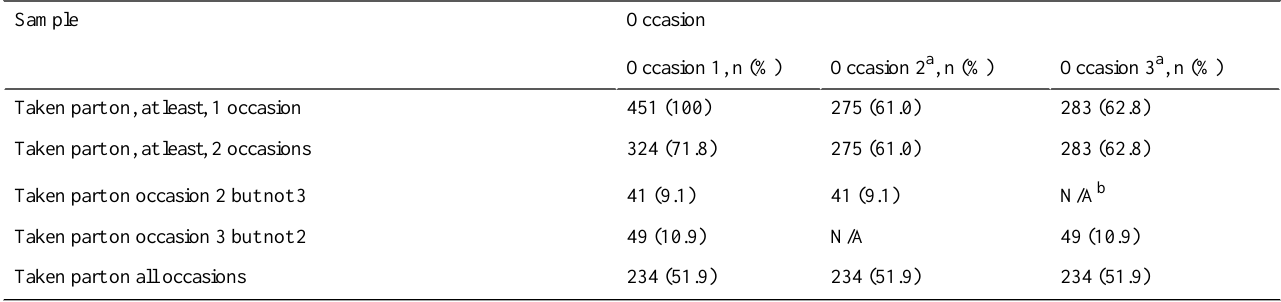
Table 1. Sample size overview